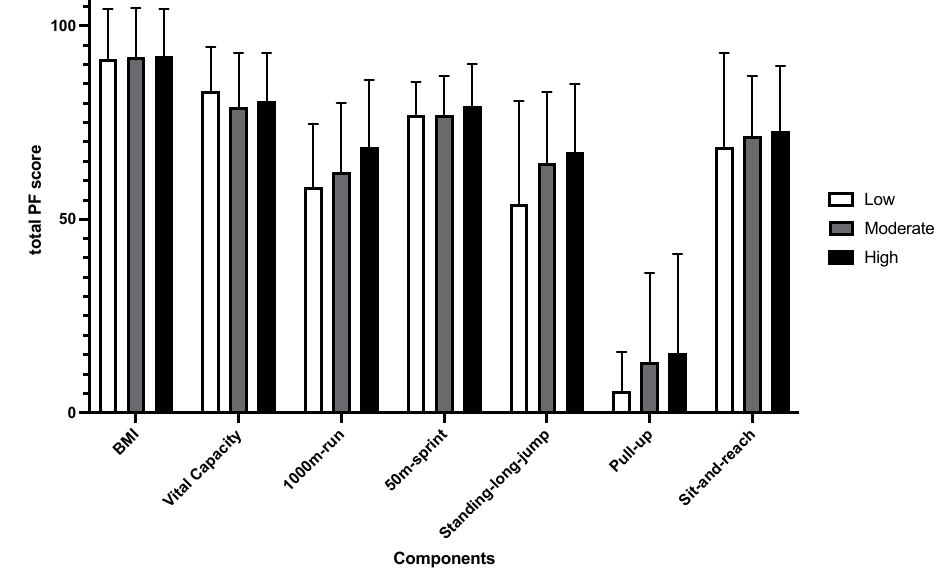
Figure 6. Mean and standard deviation of PF components at different PA levels in males.